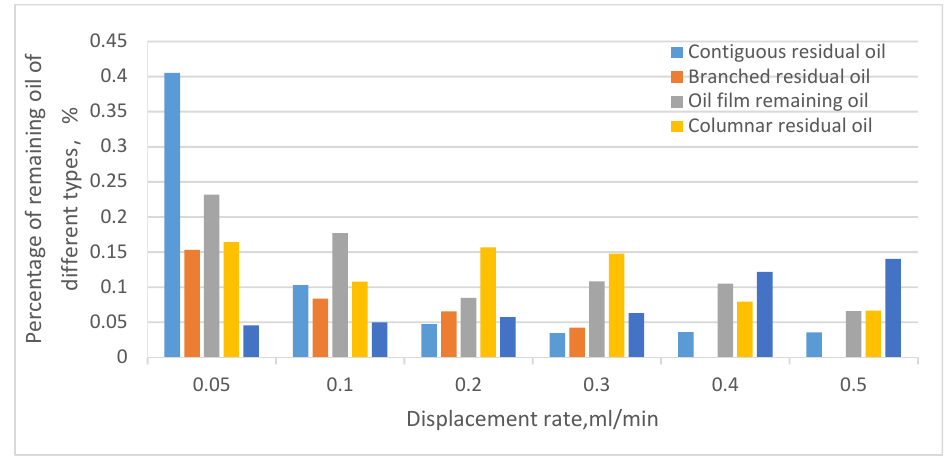
Figure 9. Comparison histogram of different types of remaining oil area with different displacement rates.